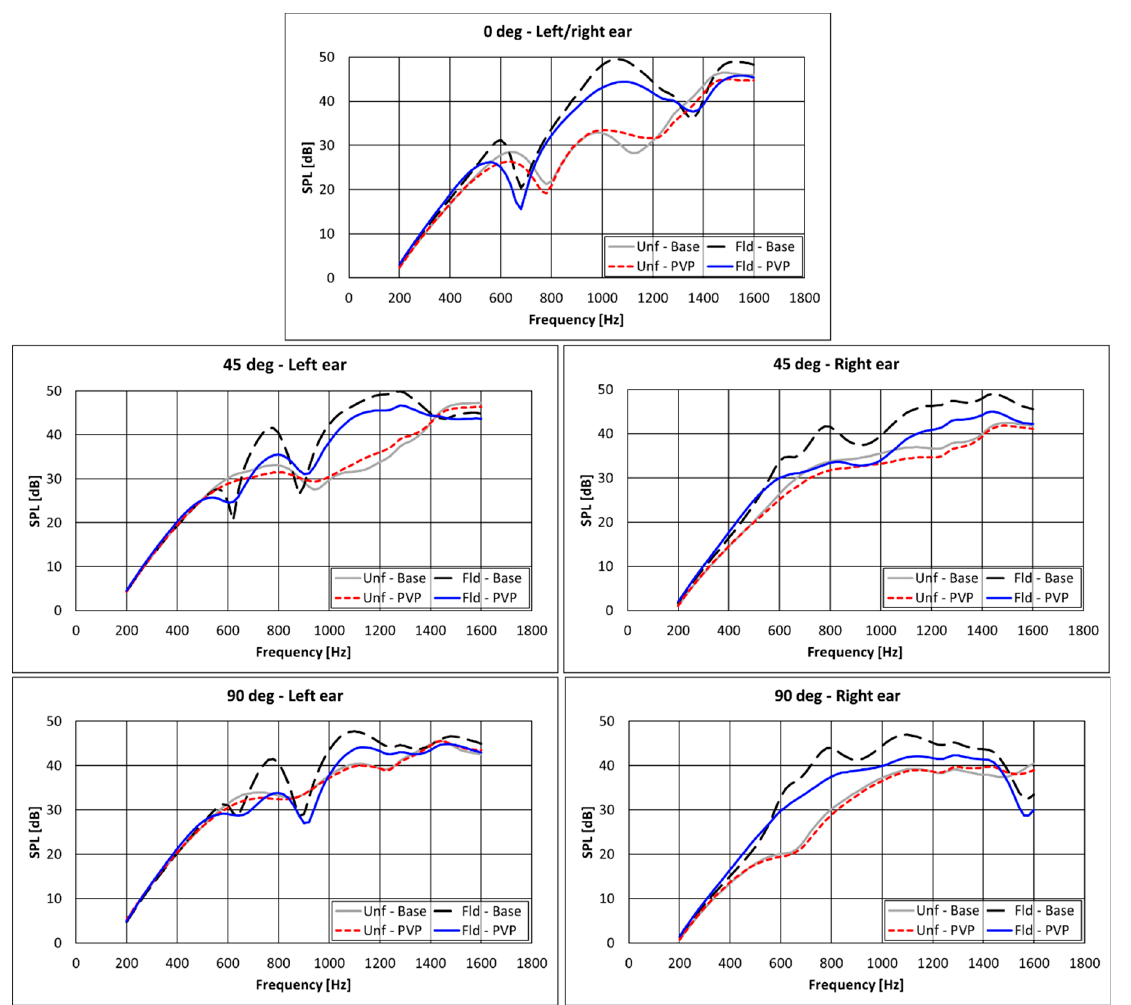
Figure 12. Numerical results in terms of SPL spectra for different headrest’s configurations. Monopole source at a distance equal to 75 cm. “PVP” or “Base” refer to the configurations with or without the PVP + silica nanofibrous insertions in the caps.